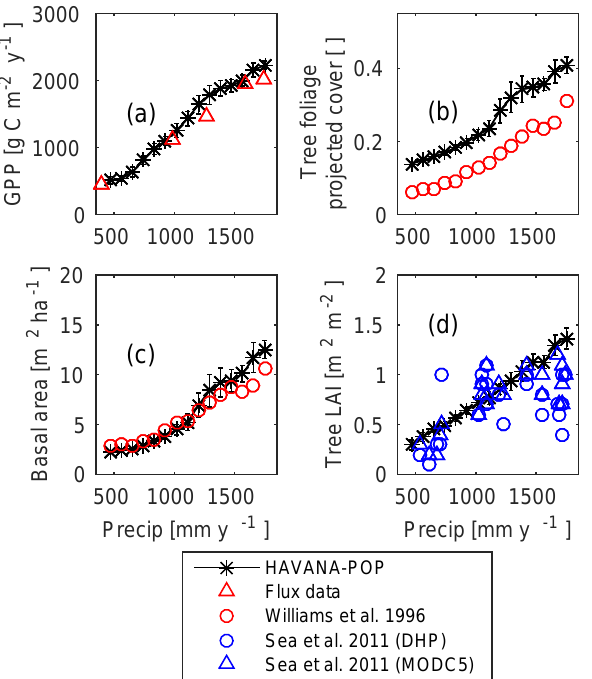
Figure 5. Time-averaged (1964–2013) HAVANA-POP output vari- ables: variation with rainfall and comparison with observation- based estimates. (a) Gross primary production (combined tree and grass components) and comparison with mean annual GPP from flux data (averaged over observation period); (b) annual average tree foliage projected cover and comparison with Williams et al. (1996); (c) tree basal area and comparison with Williams et al. (1996); and (d) dry-season tree LAI (September 2008) and comparison with Sea et al. (2011) estimated from digital hemispheric photography (DHP) and the MODIS Collection 5 product